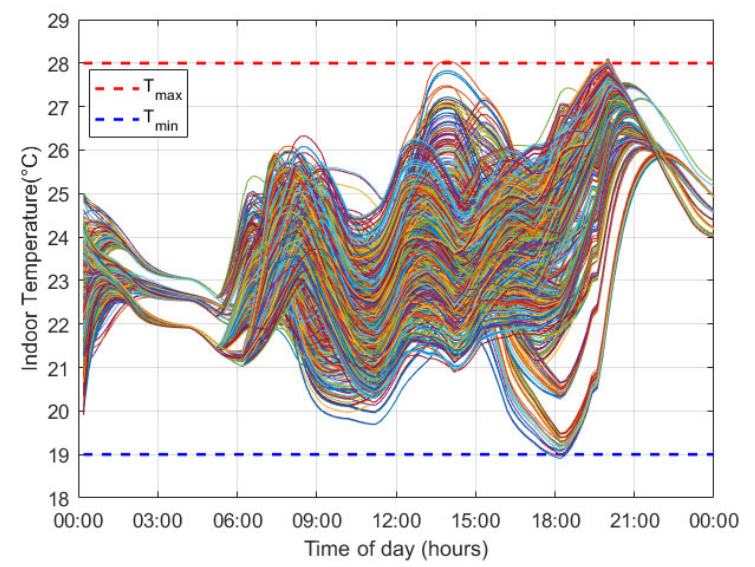
Figure 18. Internal temperatures of all building thermal zones (optimization level 3).